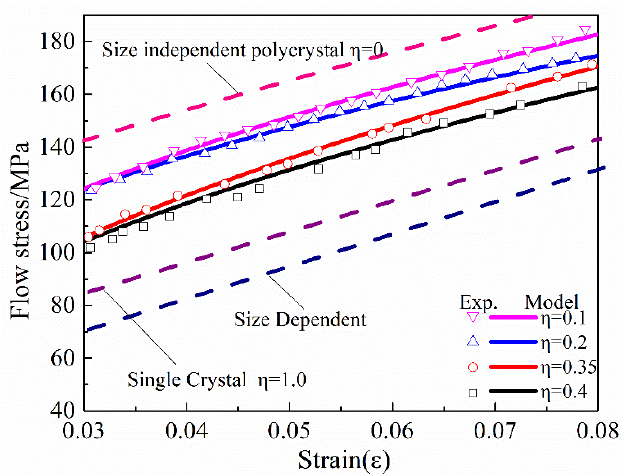
Figure 7. Comparison of calculated and experimental results for 200 μm diameter fine wires. The figure includes a size-related and a size-independent section.